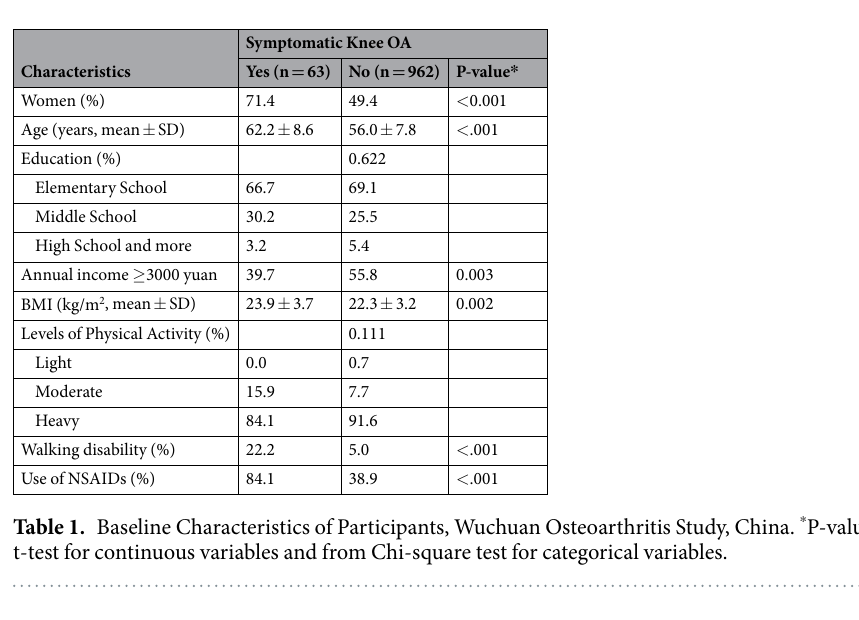
Figure 1. A directed acyclic graph to describe the hypotheses: we decomposed the total effect of knee symptomatic osteoarthritis (SxOA) on all-cause mortality into two components: 1) the indirect effect (or mediated effect), i.e., the effect of knee SxOA on all-cause mortality mediated through either a walking disability (knee SxOA → walking disability → death) or Nonsteroidal antiinflammatory drugs (NSAIDs) use (knee SxOA → NSAIDs → death), and 2) the direct effect, i.e., the effect of knee SxOA on all-cause mortality (knee SxOA → death) that was not through either a walking disability or use of NSAIDS. The dotted line between walking disability and NSAIDs indicated that the time sequence was uncertain. CF: confounders.